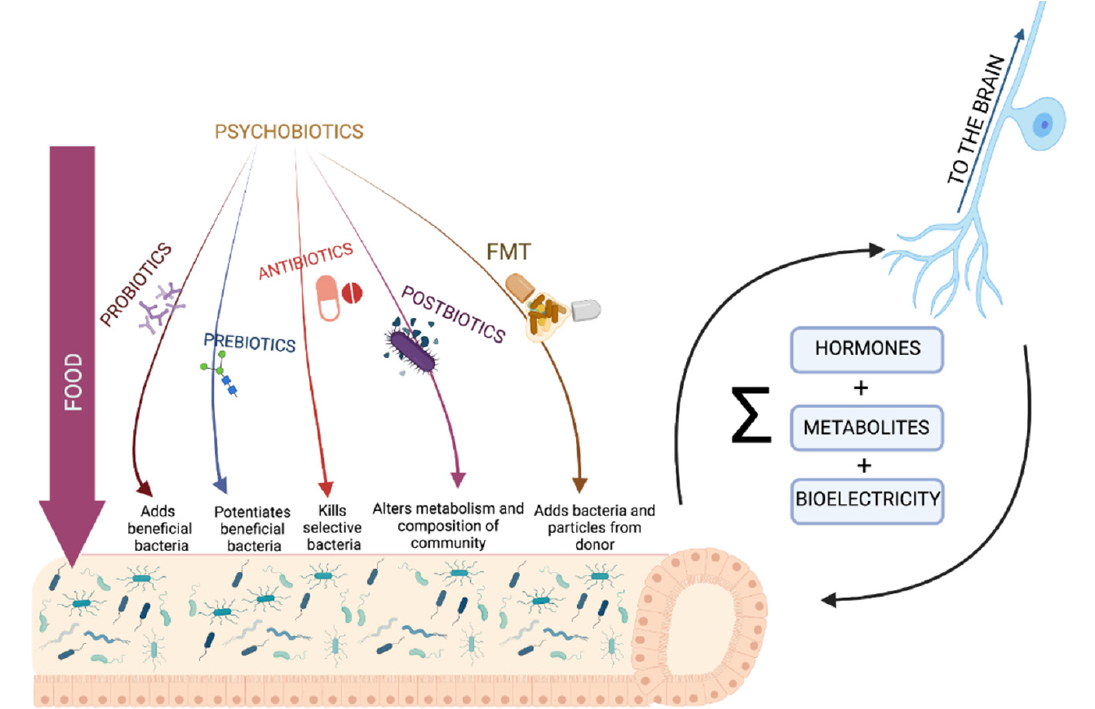
Figure 2. Microbiota–gut–brain–axis-targeted approaches. Food and psychobiotics [114] are the main exogenous factors whose impacts on the brain are mediated through gut bacteria. The pathways for bacteria–brain bidirectional communication, although still largely unknown, could involve hormones; metabolites; and, as recently proposed, bioelectrical signals [39,40]. FMT, fecal microbiota transplantation. Created with BioRender.com (accessed on 25 July 2021).